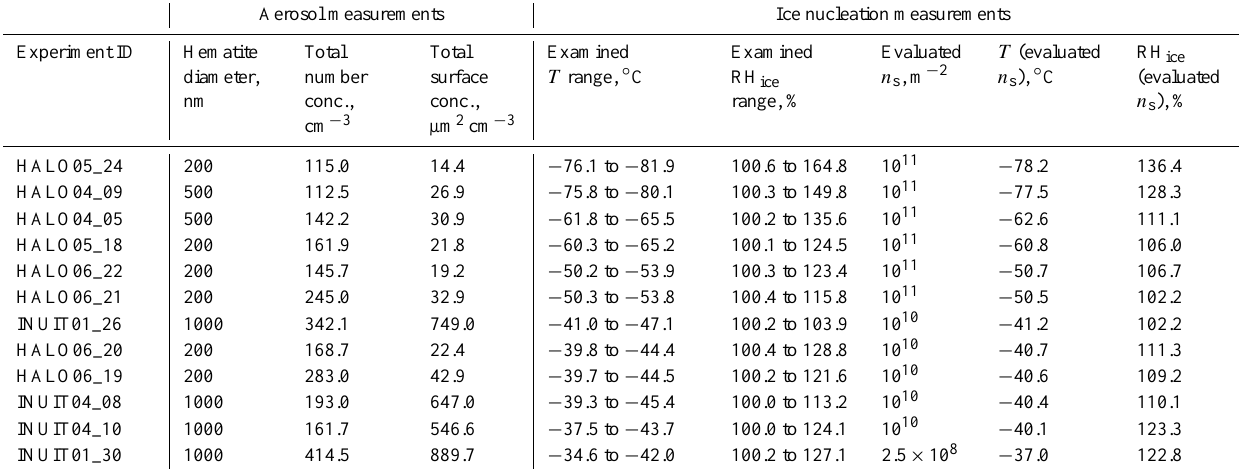
Table 1. Summary of aerosol measurements and AIDA ice nucleation experiments. All HALO experiments are from Skrotzki et al. (2013). Aerosol measurements Ice nucleation